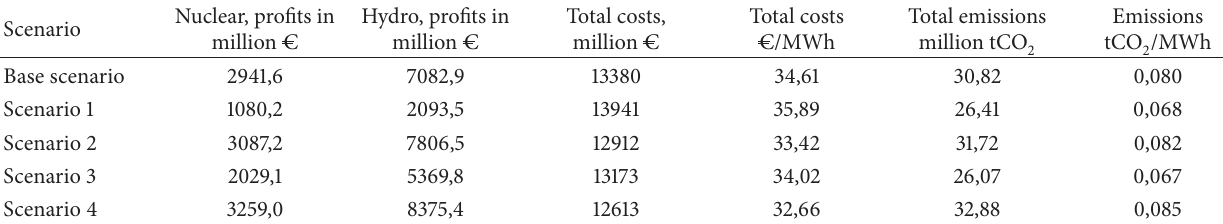
Table 4: Profits, costs, and